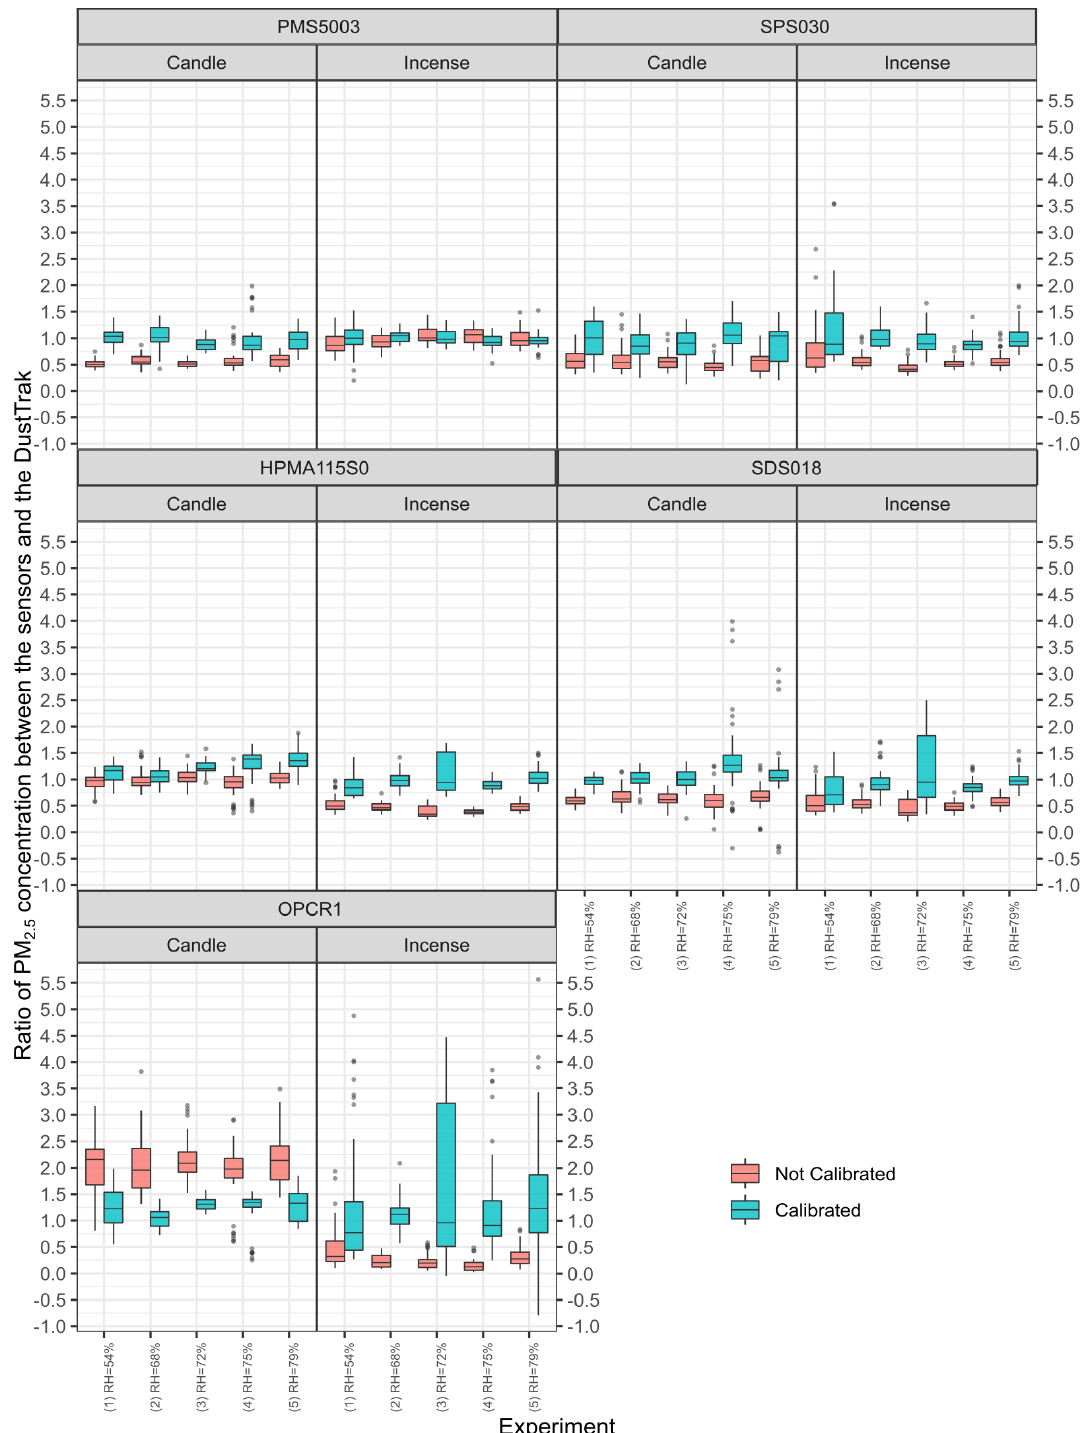
Figure 8. Ratio of the maximum value of the peaks measured by the sensors against the maximum value of the peaks measured by the DustTrak before and after calibration for each experiment. The box and whisker plot horizontal lines represent, from bottom to top, the lower quartile, the median and the upper quartile. The vertical lines are drawn to the smallest and the largest data point that fall within 1.5 times the interquartile range below the lower quartile and above the upper quartile respectively. Values outside these range are considered as outliers and plotted as